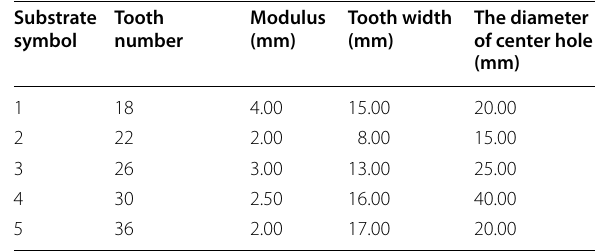
Table 1 Parameters of basic